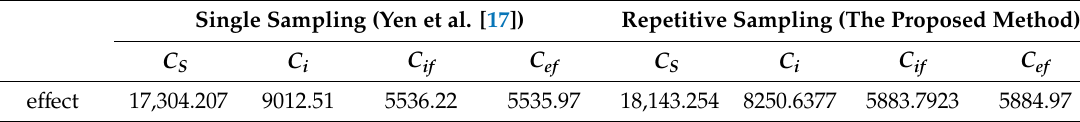
Table 5. Influence of